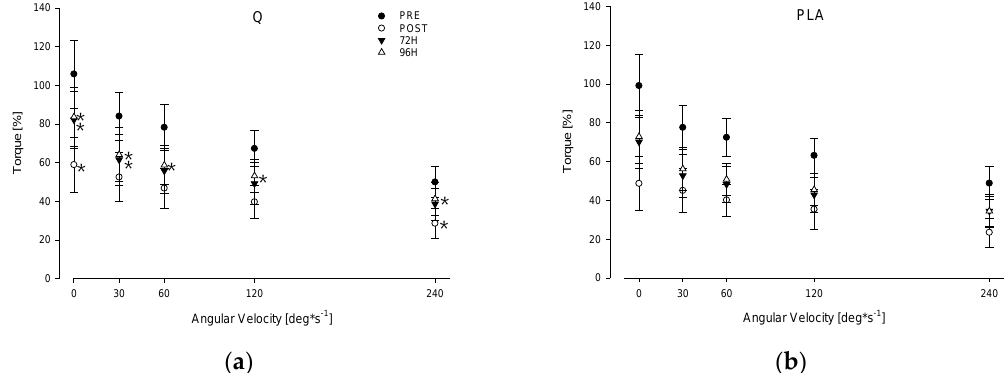
Figure 3. Force–velocity (FV) relationship in Q ( a ) and PLA ( b ) conditions before (PRE) and after the EEIMD (POST, 72 h, 96 h). Mean ± SD * (cid:44) from PLA p < 0.05. Table 1. MFCV in Q and PLA conditions before, after the EEIMD and during the recovery at the different angular velocities of the FV task.